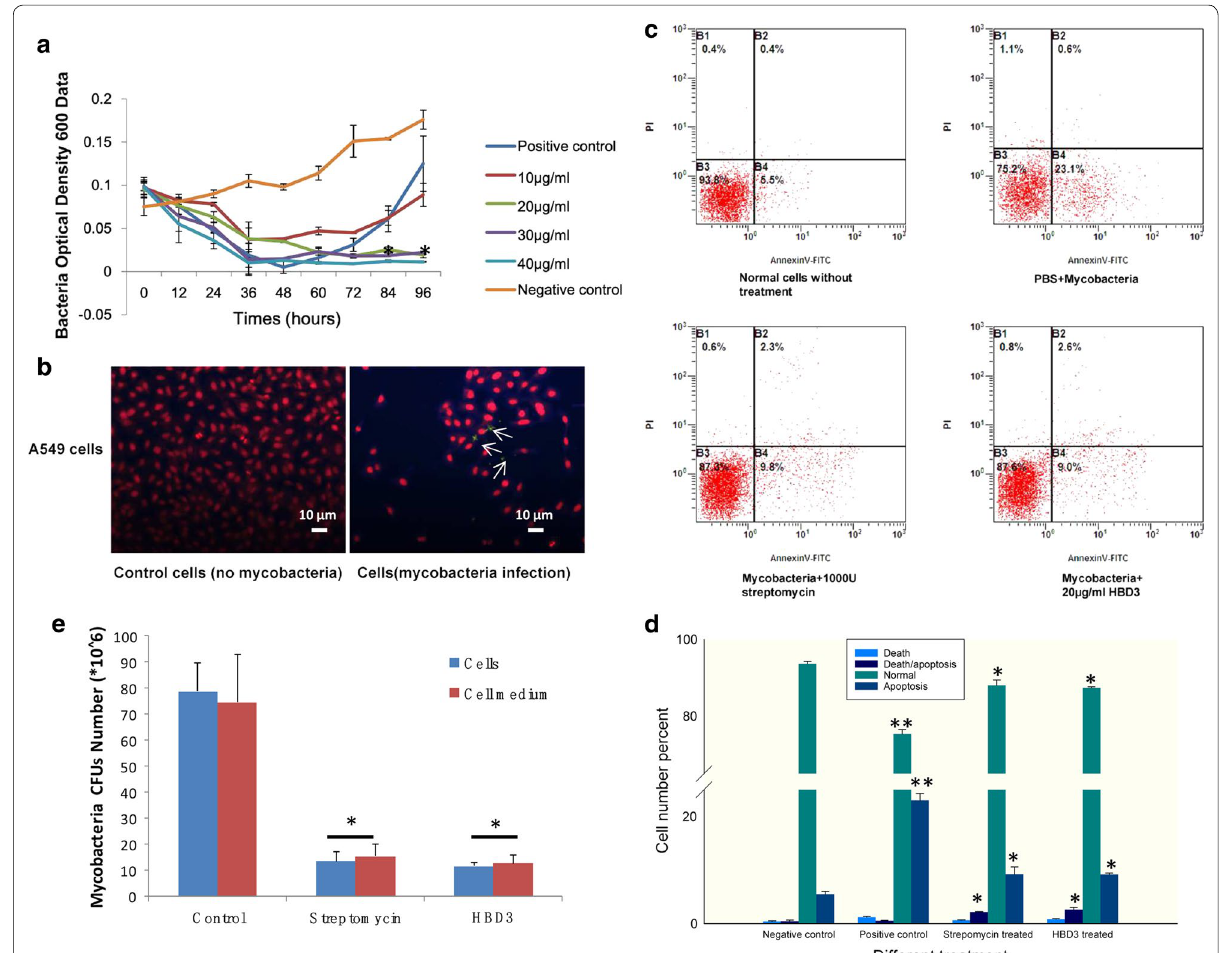
Fig. 4 Anti- Mycobacterium bovis capacity of rHBD3 protein to A549 cells. a M. bovis growth curve after incubation with different concentrations of HBD-3. Negative control is M. bovis with Middle Brook 7H9 broth. Positive control is M. bovis with streptomycin (1000 U/ml). b Mycobacteria invasion tests. Yellow spots in the figure are Mycobacteria . c Cell apoptosis analysis of A549 cells infected by M. bovis with different treatments. d The data of cell apoptosis and death ratio analysis of A549 cells infected by M. bovis with different treatments. All the experiments were replicated three times and the changes are presented as mean SEM. P values < 0.05 were considered as statistically significant. e CFU tests in A549 cells and its medium ± (*P <